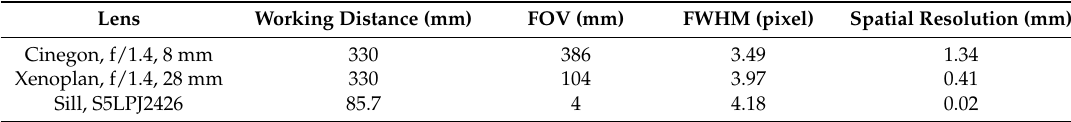
Table 3. Results of the spatial calibration of the